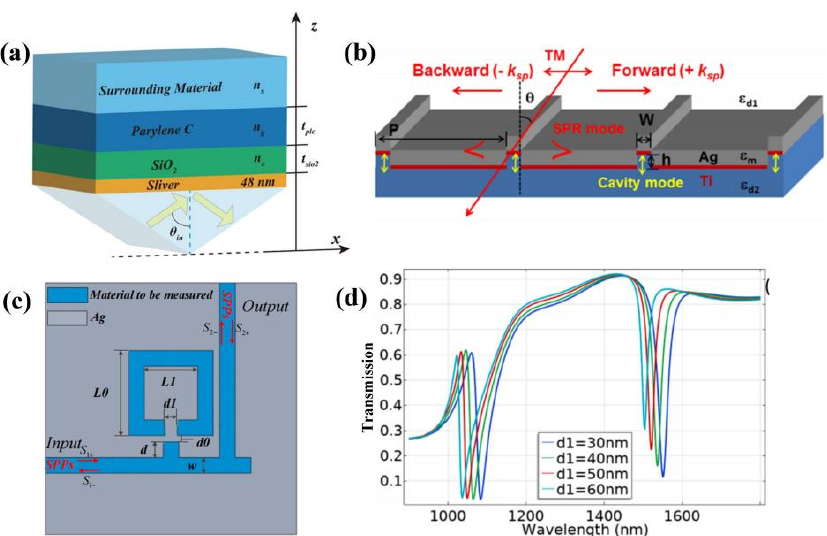
Figure 6. ( a ) Schematic of metal–dielectric multilayer Kretschmann configuration under TM–polarized light. Adapted with permission from Ref. [96]. ( b ) Schematic configuration depicts the geometrical parameters of capped nanoslits. Adapted with permission from Ref. [100]. ( c ) 2D schematic describing the critical parameters of the sensor. Adapted with permission from Ref. [109]. Copyright (2022), Elsevier Ltd. ( d ) The transmission spectrum obtained when opening size (d1).